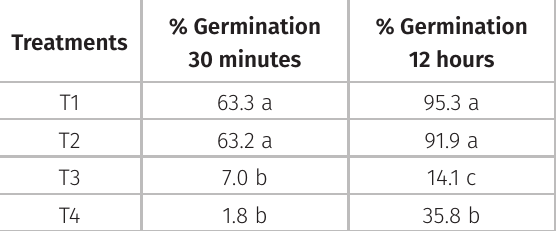
Means followed by the same letter in a column do not differ by Tukey’s test at 5%